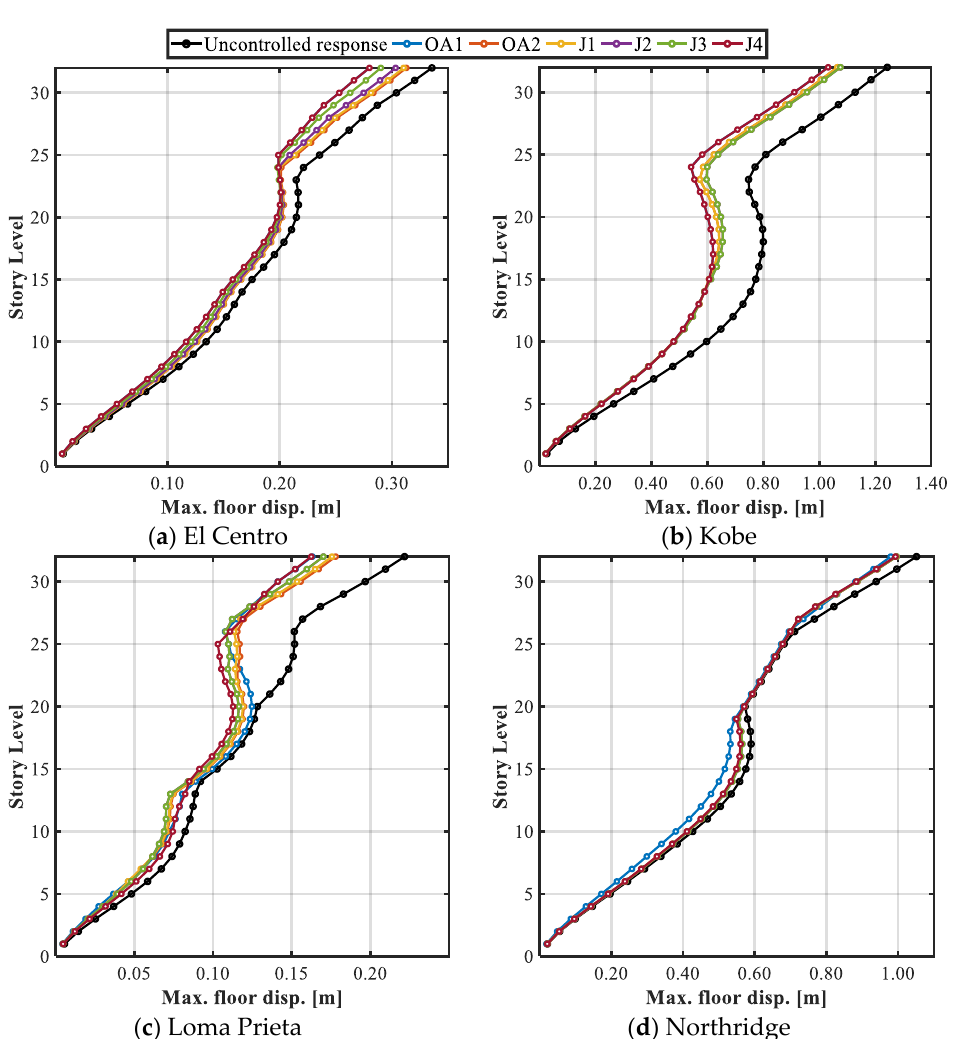
Figure 7. Maximum floor displacement at each story level of the structure equipped with TMDs with µ = 0.02. The numerical results show that, using µ = 0.02 TMD, the reduction of the